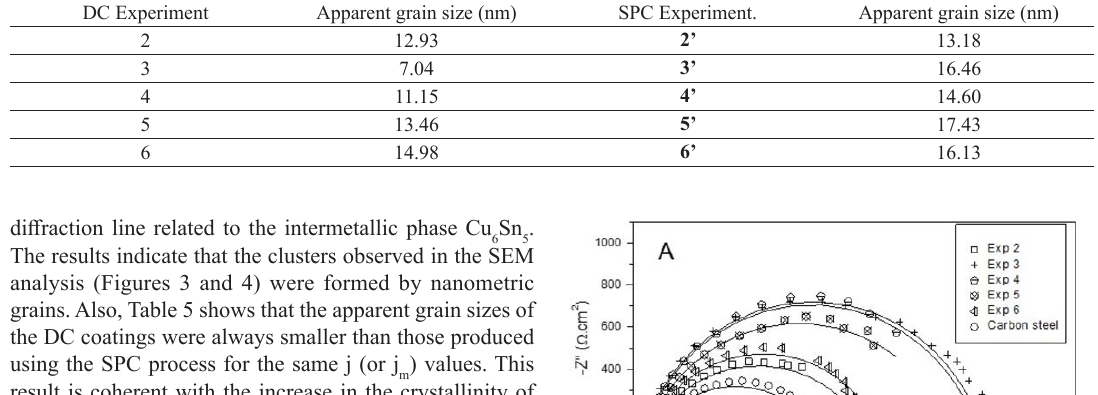
Table 5. Apparent grain size calculated for selected Cu-Sn coatings produced by DC and SPC electrodeposition processes. DC Experiment